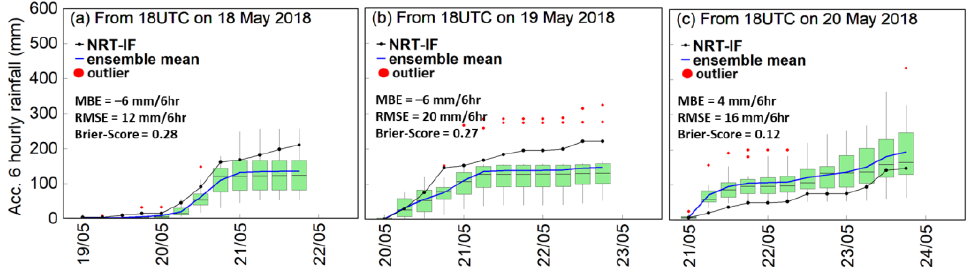
Figure 11. Same as Figure 10 but for the 2018 flood event starting from ( a ) 18 UTC on 18 May; ( b ) 18 UTC on 19 May; and ( c ) 18 UTC on 10 May 2018 .